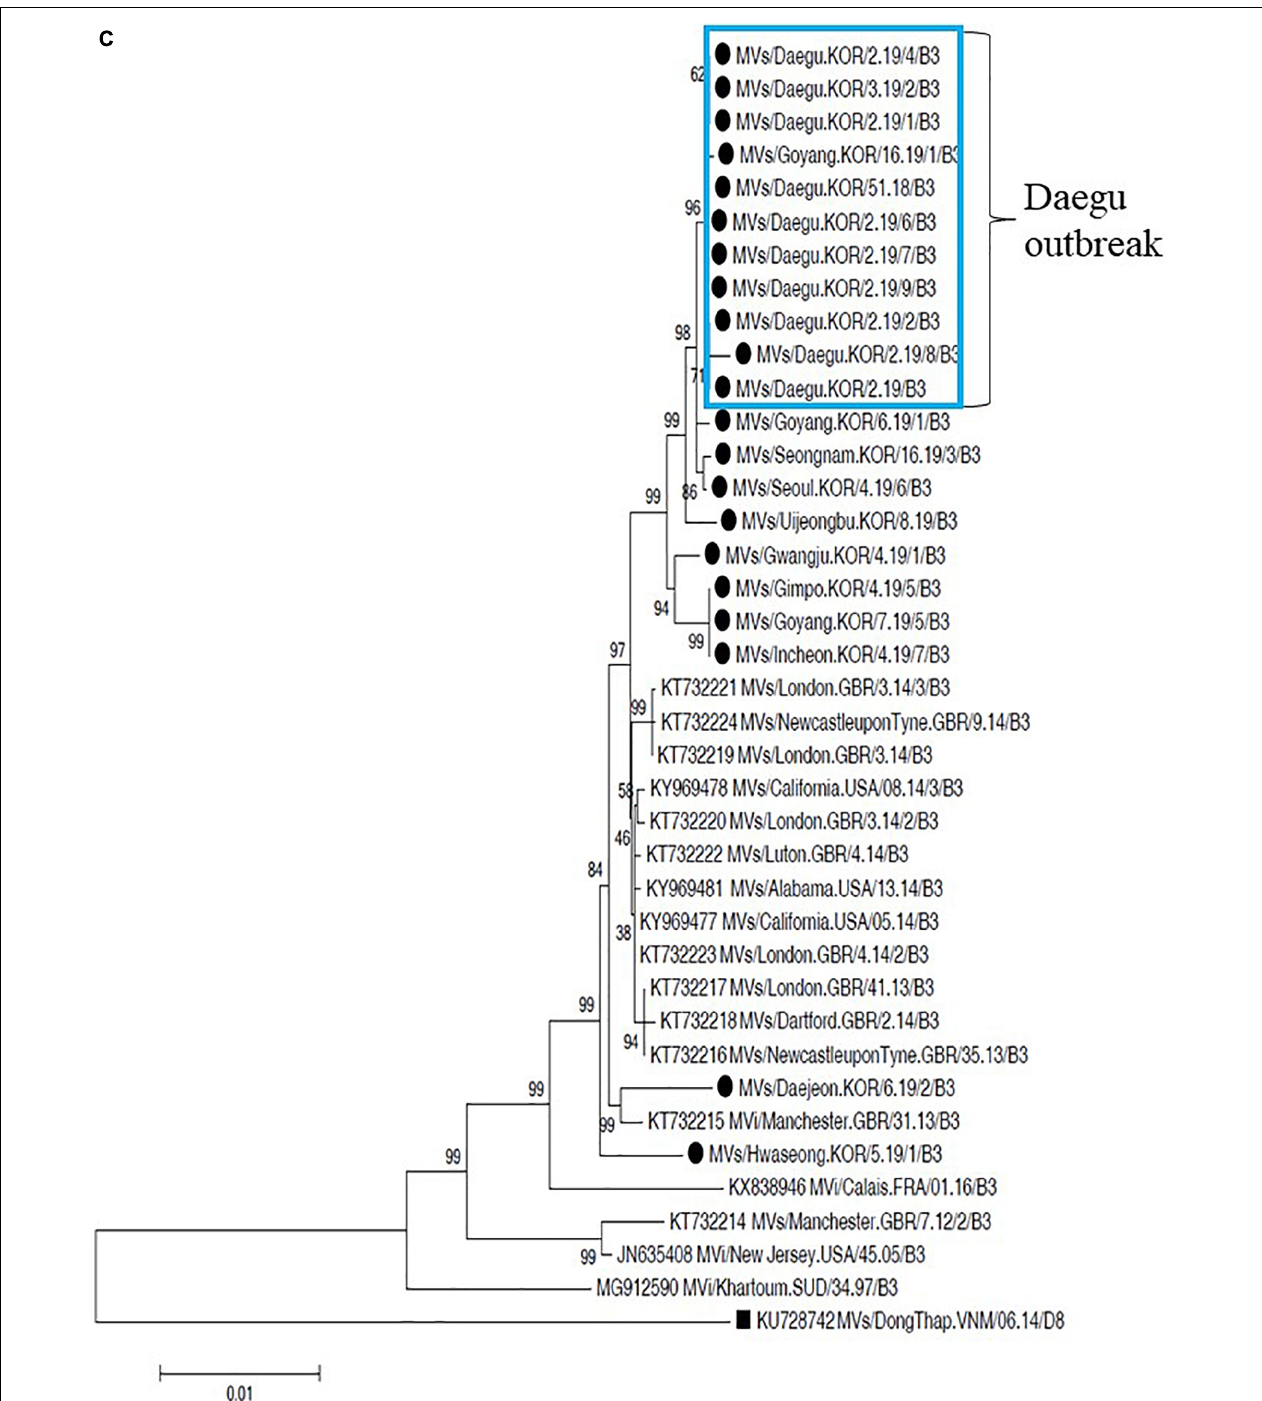
FIGURE 3 | Phylogenetic analysis of MeV genotype D8 strains based on nucleotide sequences using the neighbor-joining tree. Values on branches are shown as percentages on the basis of 1,000 bootstrap replicates. The black dot indicates the MeV genotype D8 relevant to Korean occurrences in 2019 and named strains accepted in MeaNS. The tree was rooted with respect to the genotypes D8 and B3 based on WHO and GenBank reference sequence. (A) N-450 gene analysis of MeV genotype D8. The black squares indicate the MeV genotype B3 reference using genotype D8 outgroup. (B) MF NCR gene analysis of MeV genotype D8. The black squares indicate the MeV genotype D8 reference using genotype B3 outgroup. (C) MF NCR-H gene analysis of MeV genotype D8. The black squares indicate the MeV genotype D8 reference using genotype B3 outgroup. The skyblue box indicates Daegu outbreak.